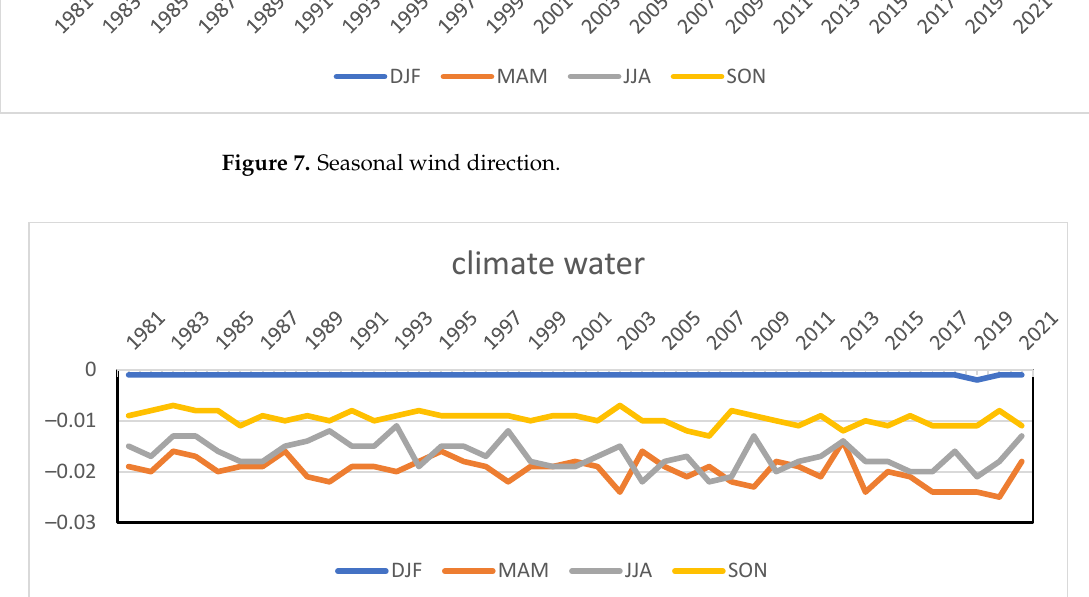
Figure 8. Yearly change of seasonal climate water content.